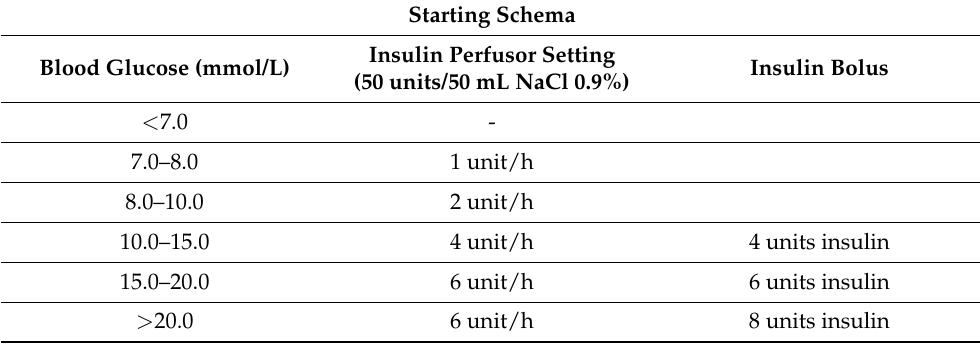
Table 1. Starting scheme of the glucose management protocol used in the study.